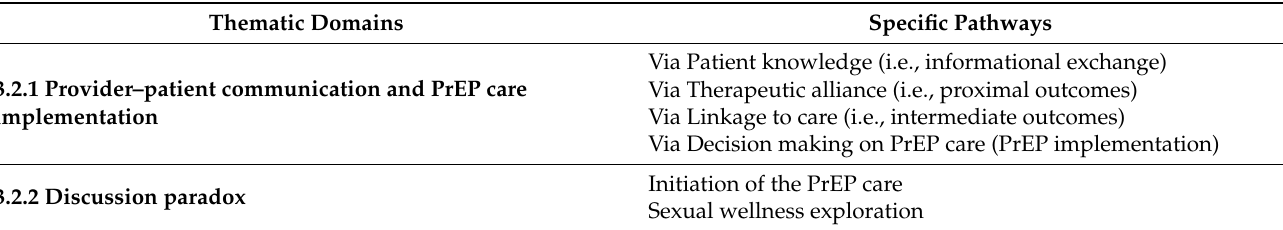
Table 2. Key findings based upon the conceptual